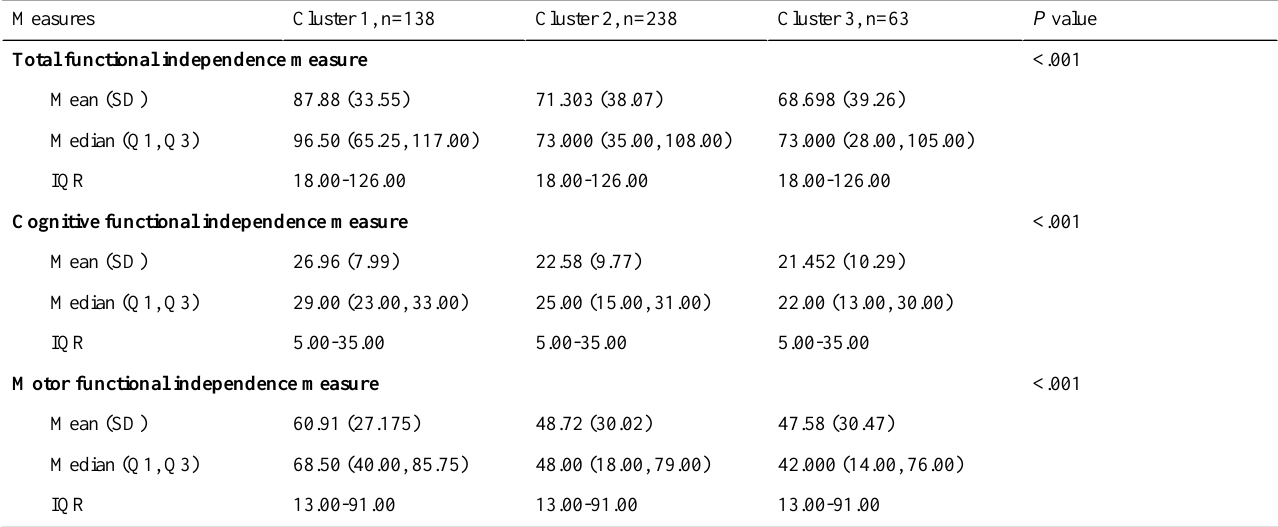
Table 3. Total functional independence measure, cognitive, and motor subtotals by cluster (N=439).